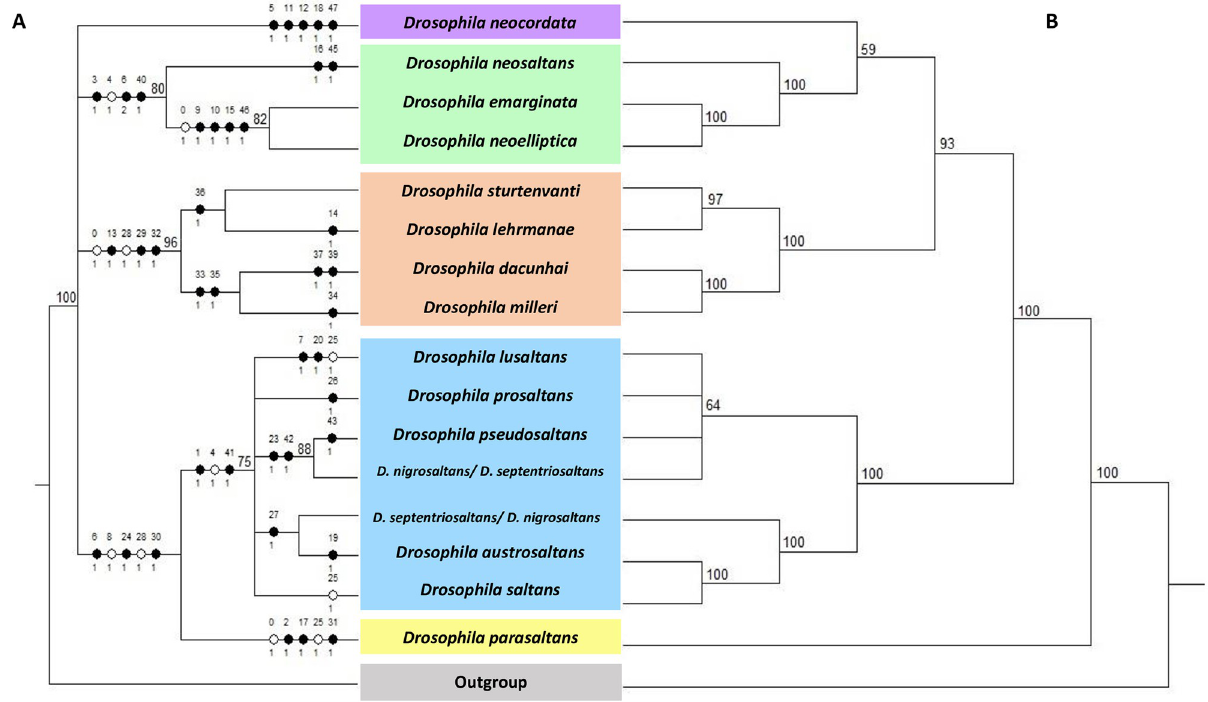
Fig 1. Comparison between morphological and molecular trees of the saltans group. (A) Phylogenetic relationships inferred by maximum parsimony based on morphological markers. Black circles correspond to nonhomoplastic apomorphies, and white circles correspond to homoplastic apomorphies, with character numbers above and state codes below (see Table 1). The bootstrap (BS) support values ( � 70%) are shown above corresponding branches. (B) Phylogenetic relationships inferred by the analysis of the concatenated sequences of the mitochondrial markers COI and COII . Bayesian posterior probability (PP) is shown as percentage on each